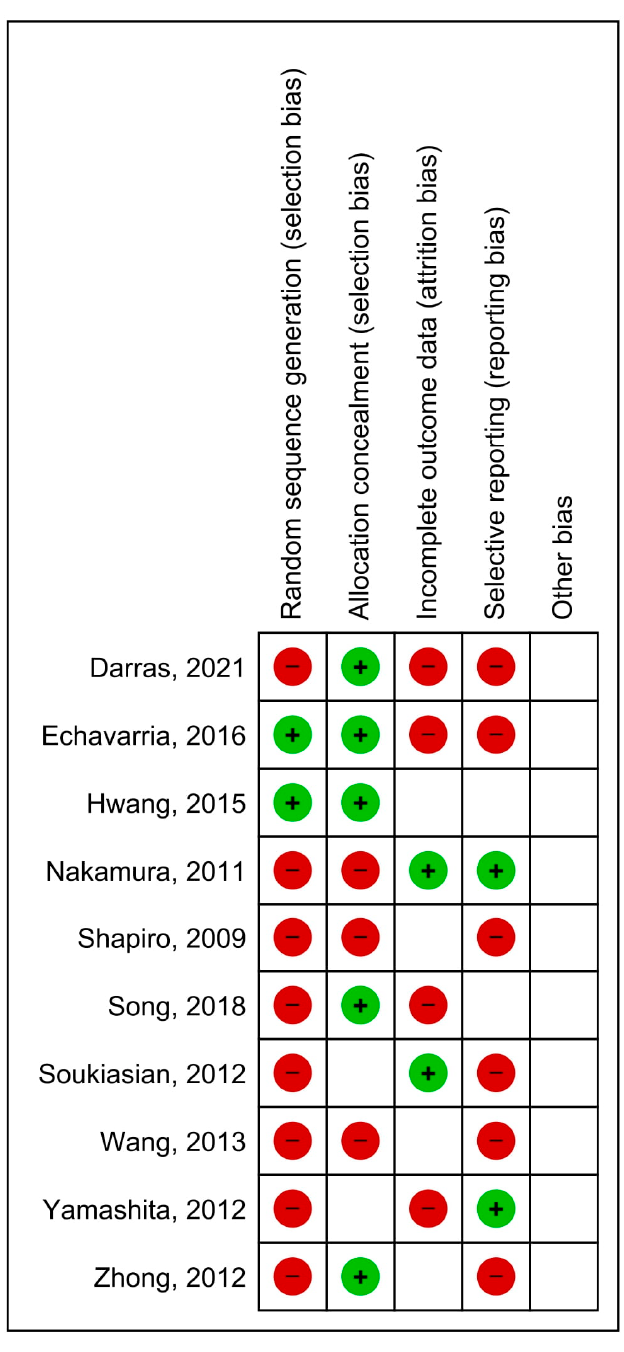
Figure 1. Risk of bias summary. Authors’ assessments of each risk of bias item for each study included. The green and red circles correspondingly represent a low and high risk of bias [8,12–20].